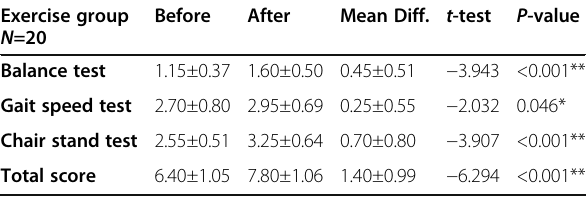
Table 2 Effect of exercise on short performance battery test and its components